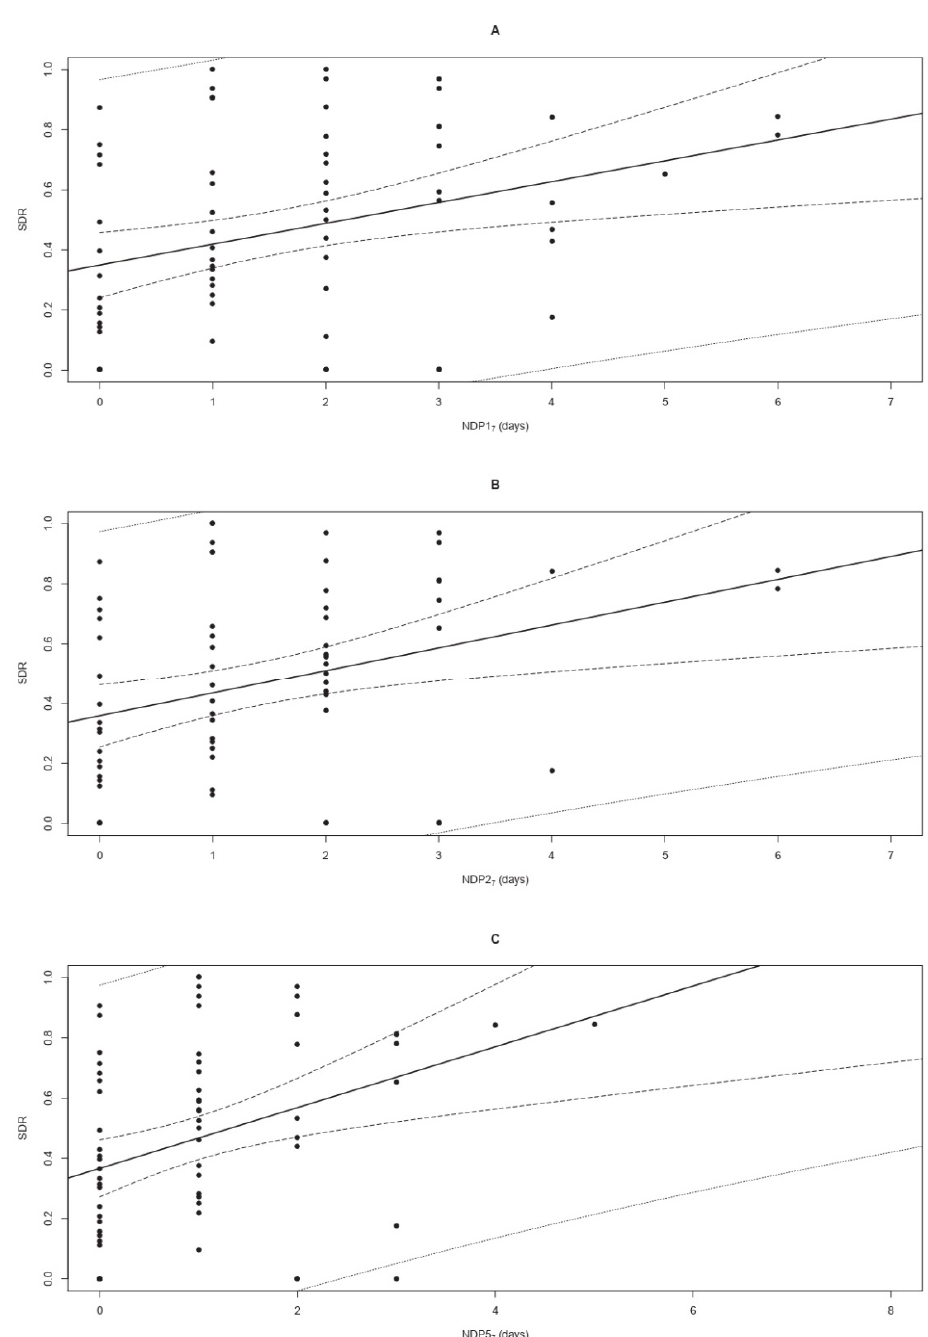
Figure 4. Linear regressions modelling the propagule deposition pattern of Cryphonectria parasitica to the number of days with precipitations over 1, 2, and 5 mm (NDP1 7 —panel A ; NDP2 7 —panel B ; and NDP5 7 —panel C , respectively) occurring during a timeframe of 7 days. The graphs show the positive correlation between increasing values of NDP1 7 , NDP2 7 , and NDP5 7 (on the x-axis) and the raising standardized deposition rate (SDR) of C. parasitica (on the y-axis). The points indicate the observed SDR in sites TS1 and TS2, while the continuous lines represent the equations of the regression models. Confidence and prediction intervals at 95% are shown as dashed and dotted lines, respectively. Table 2. Propagule deposition of Cryphonectria parasitica modelled as a function of climatic variables . The table shows the outcomes of the ordinary least squares linear regressions (OLSLR) modelling